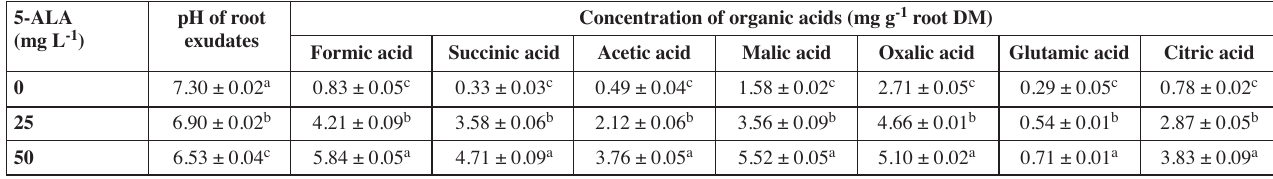
Tab. 4: Organic acid concentrations and pH in root mucilage of Portulaca oleracea in response to foliar application of different 5-ALA